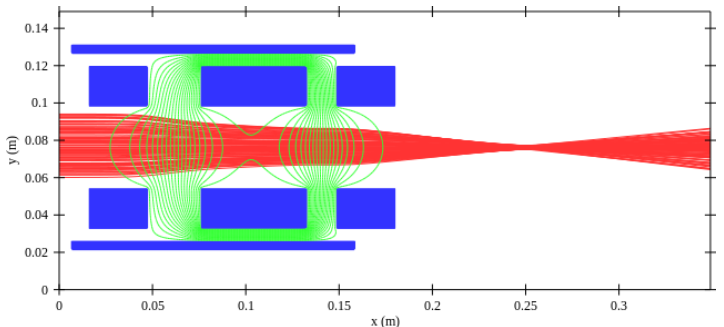
Figure 10. The asymmetrical einzel lens.